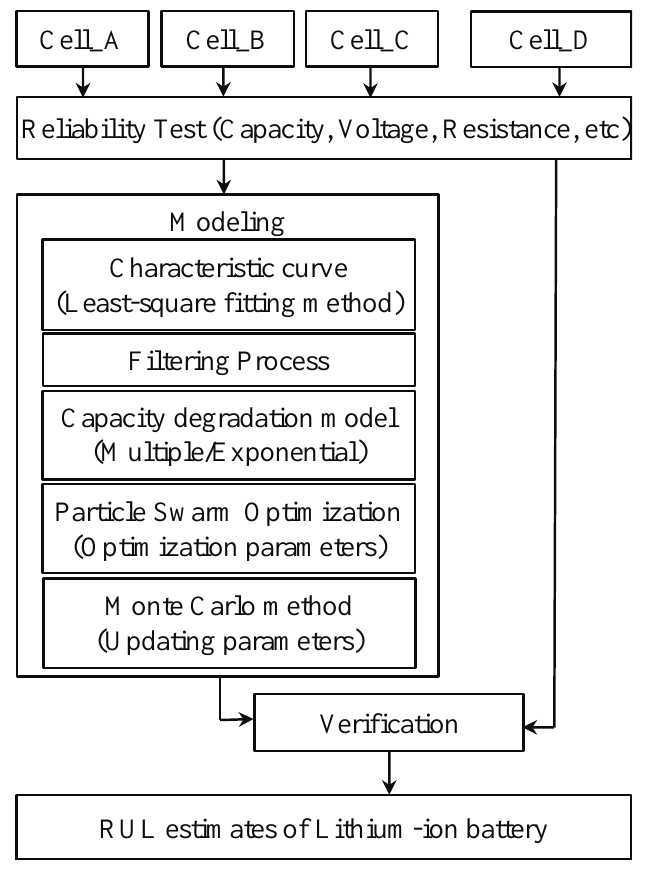
Figure 2. Algorithm of SOH modeling and RUL prediction of lithium-ion